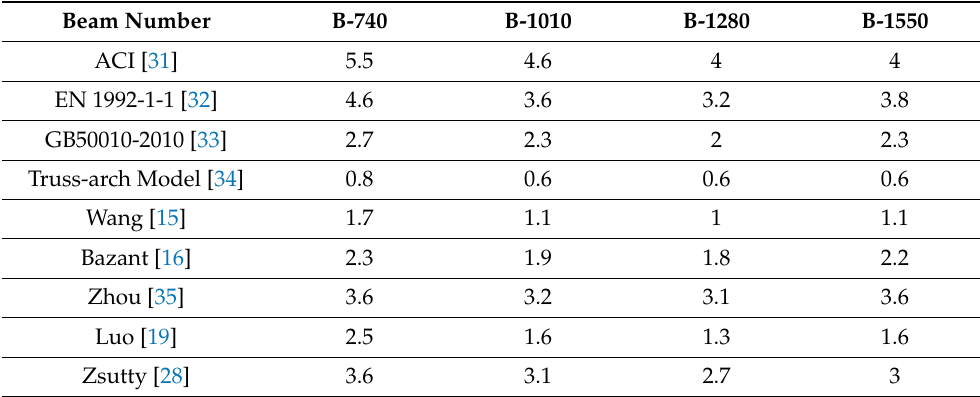
Figure 5. Comparisons of the shear capacity test values and theoretical values. Table 9. The safety reserve coefficients obtained by various shear capacity formulas.